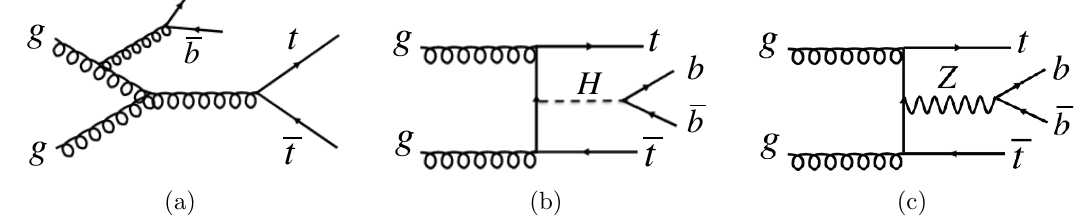
Figure 1. Example Feynman diagrams of processes leading to a t (cid:22) tb (cid:22) b (cid:12)nal state, including (a) QCD t (cid:22) tb (cid:22) b production, (b) t (cid:22) tH ( H ! b (cid:22) b ), and (c) t (cid:22) tZ ( Z ! b (cid:22) b